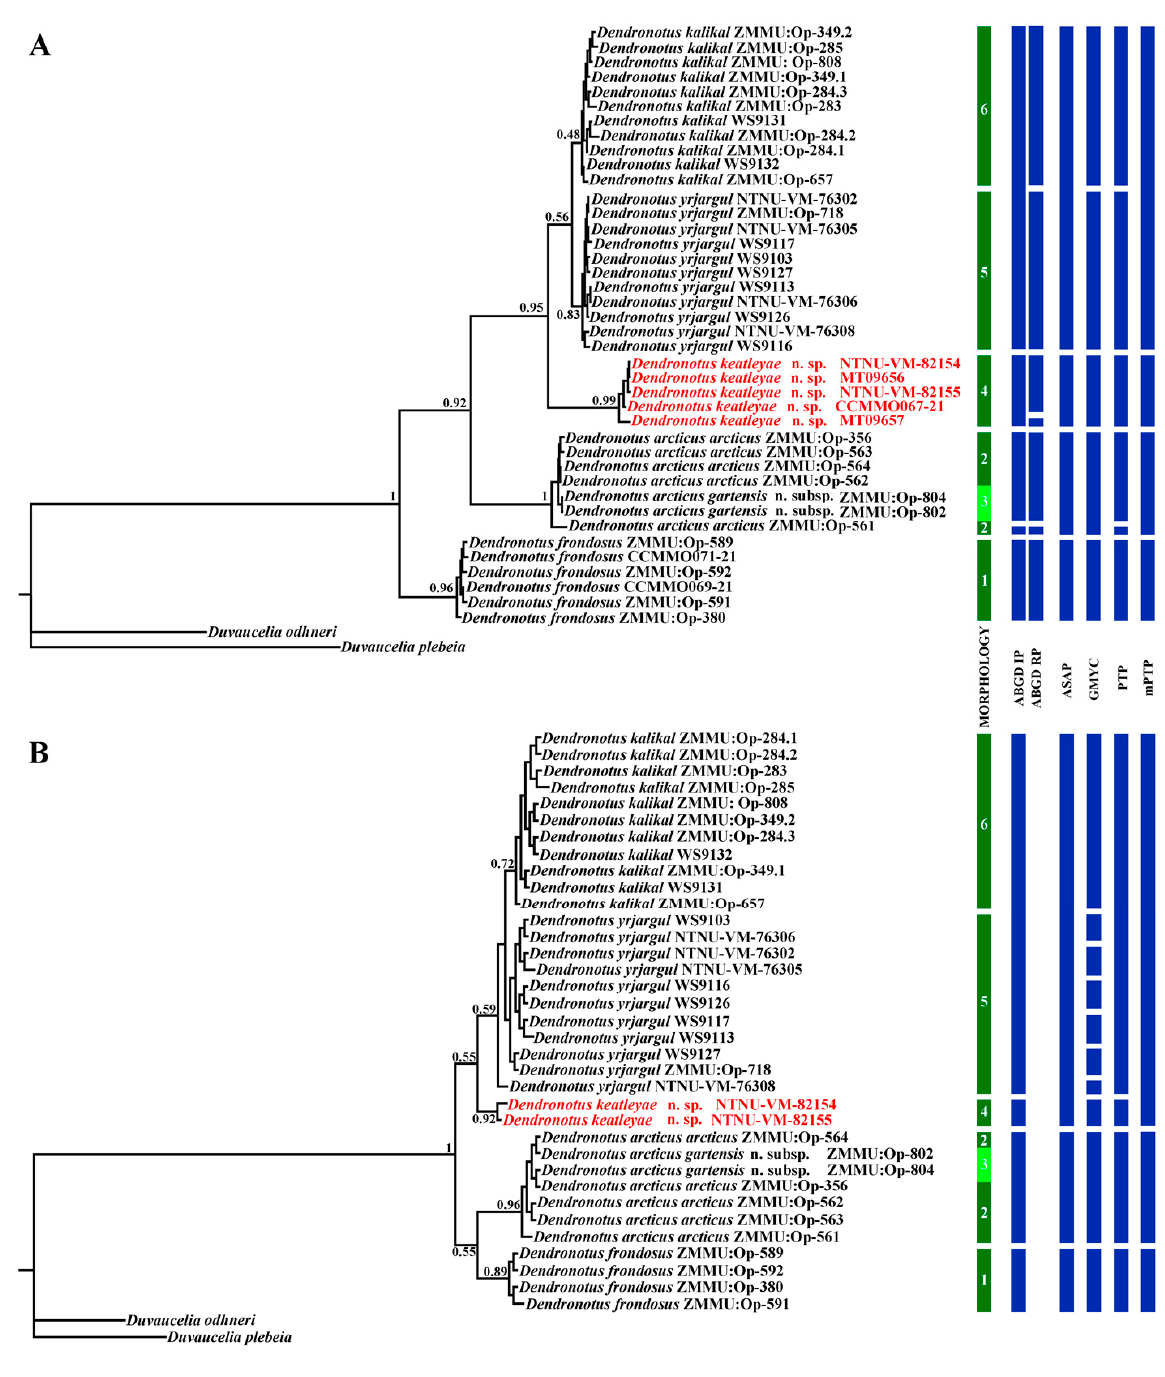
Figure 5. Phylogenetic trees based on cytochrome c oxidase subunit I ( A ) and 16S ( B ) represented by Bayesian Inference. The results of species delimitation are indicated by vertical bars. The green bars depict species recognised by morphological taxonomy (Table 2). The blue bars depict putative species recognised by the initial (IP) and recursive (RP) partitioning of ABGD, ASAP, single-threshold GMYC model, PTP, and mPTP, respectively.